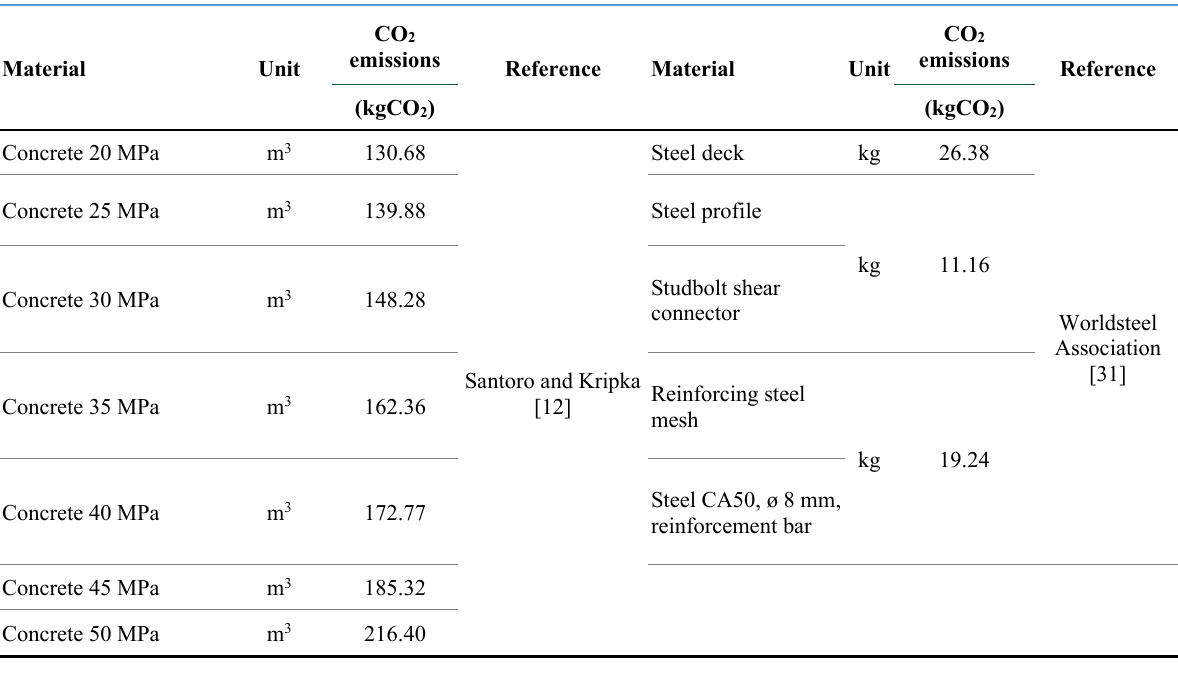
Table 1. CO 2 emission of